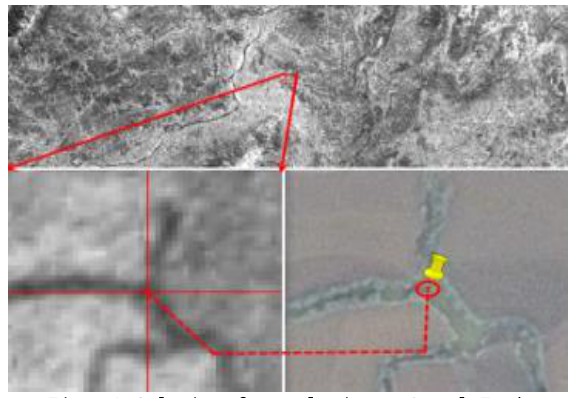
Figure 3. Selection of control points on Google Earth